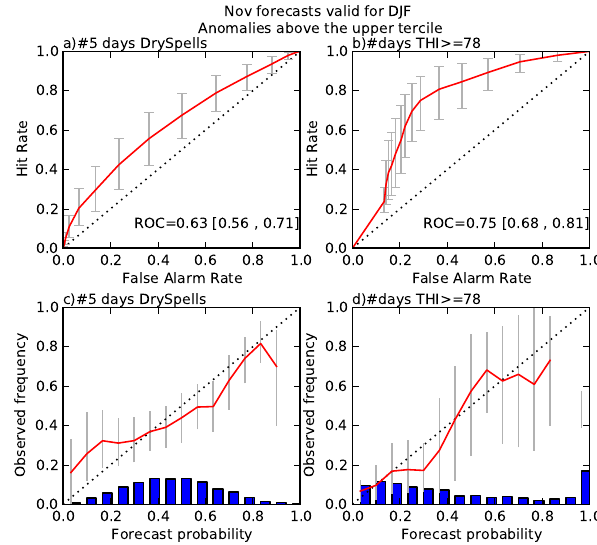
Fig. 8. ROC (a, b) and REL (c, d) diagrams for the forecast anoma- lies above the upper tercile issued in November and valid for DJF over the Limpopo region: frequency of occurrence for5-day dry spells (a, c) and frequency of occurrence of days with THI higher than 78 (b, d) . The gray error bars denote 95% confidence intervals estimated from 1000 bootstrap